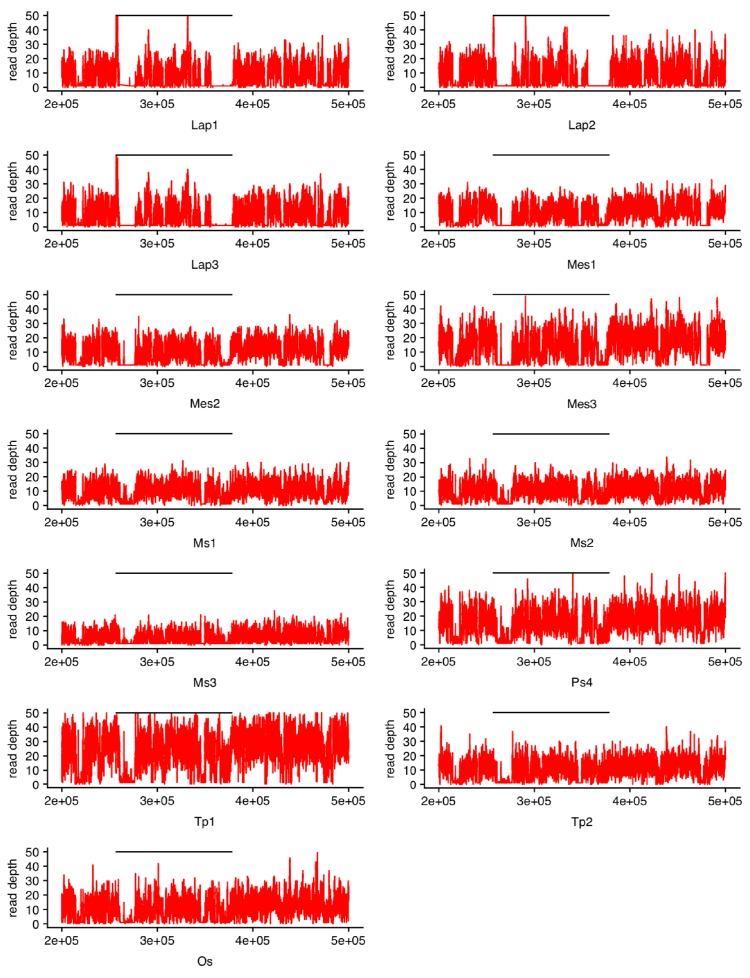
Reads from wingless individuals of different biotypes map to the wingless-specific region.The x-axis shows position along the api wingless scaffold. Read depth, on the y-axis, differs among individuals. A solid black line indicates the wingless-specific region. Abbreviations: Mes: Melilotus officinalis, Tp: Trifolium pratense, Lap: Lathyrus pratensis, Ps: Pisum sativum, Ms: Medicago sativa, Os: Ononis spinosa.